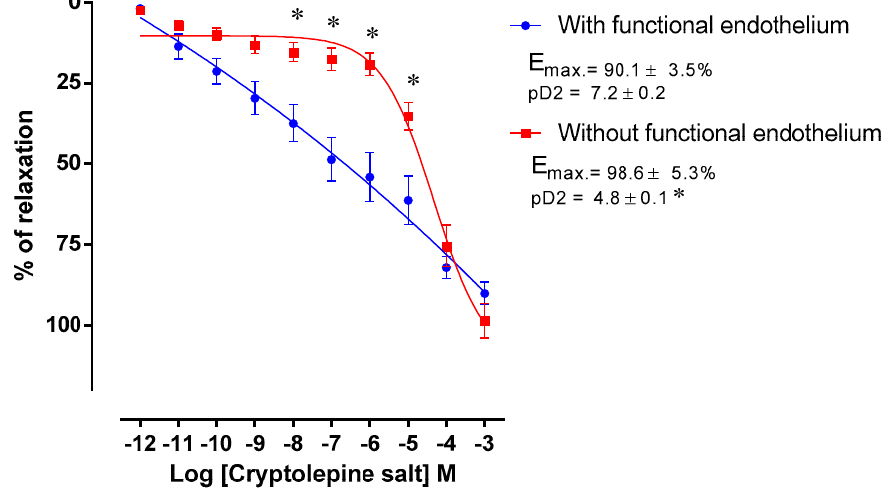
Figure 3. Concentration-response curve of cryptolepine salt (10 − 12 –10 − 3 M) in cranial mesenteric artery rings isolated from rats with functional endothelium (•) and without functional endothelium ( ■ ) pre-contracted with phenylephrine (PHE, 1 μ M). Values are expressed as mean ± standard error of mean (SEM), * p < 0.05 compared to the ring with functional endothelium.